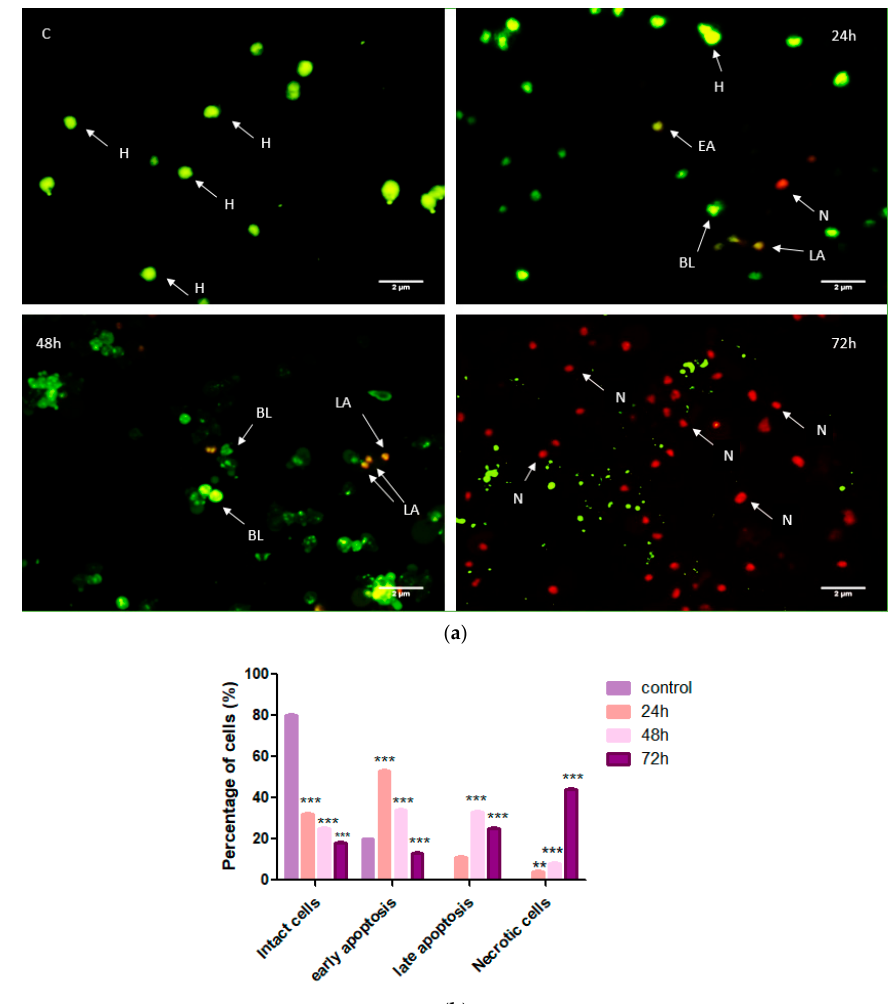
Figure 3. AO/PI staining of untreated HepG2 cells (control) and CADMN-treated HepG2 cells after 24, 48 and 72 h. The number of viable cells decreased in CADMN-treated HepG2 cells and cells going into the apoptosis phase steadily. ( a ) Morphological changes as observed under a fluorescence microscope ( b ) Quantitative analysis of cells percentage at different stages. Data were presented as mean ± SD. ** p < 0.01, *** p < 0.001 indicates significant di ff erences as compared to untreated